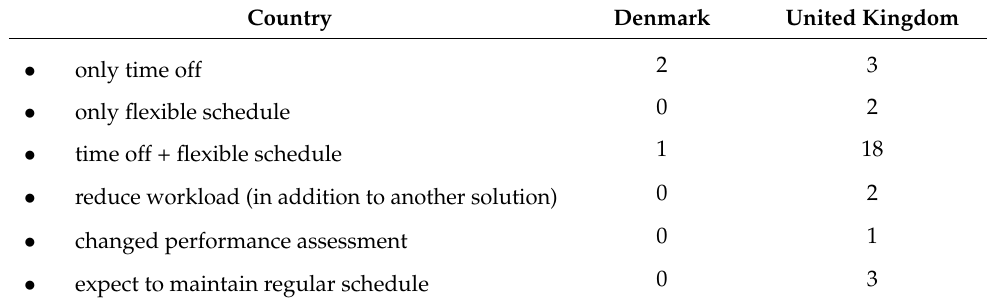
Table 4. Distribution of recommended solutions to the problems posed by working from home for em-ployees with additional care responsibilities. The numbers represent the number of universities which proposed a certain solution (rows) within a country (columns). Country Denmark United